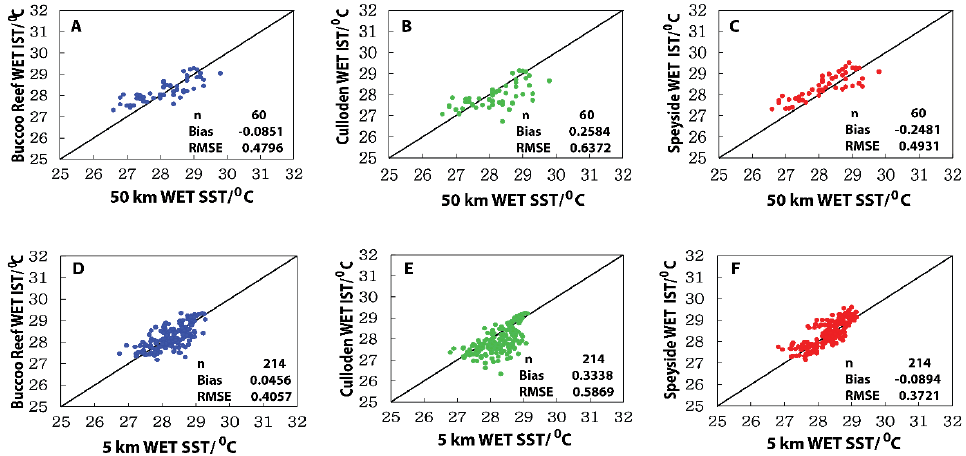
Figure 6. Comparison of 50 km SST ( A – C ) and 5 km SST ( D – F ) with in situ temperature (IST) measurements for the 2014 wet season at Buccoo Reef ( A , D ), Culloden ( B , E ) and Speyside ( C , F ), Tobago. The black line is the line of unity. Positive bias indicates SST greater than IST. This coastal influence mostly affects Culloden, which recorded the highest RMSE values amongst the three reef sites during the wet season (Figure 5B,E). For Culloden there was also better representation of IST by the 50 km SST than the 5 km SST, potentially due to the small coverage of water by the 5 km pixel or the sheltered nature of the site.